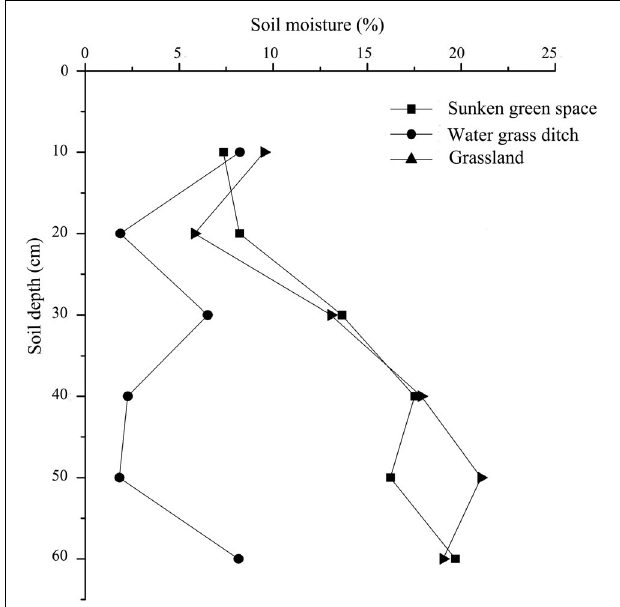
FIGURE 8 | Changes of average soil moisture content under different sponge measures during the rain event.